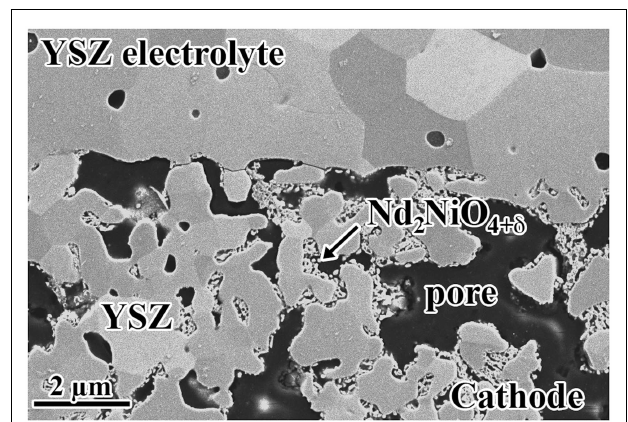
FIGURE 5 | SEM image of a mT-SOFC cathode/electrolyte interface showing ND-nickelate particles infiltrated into porousYSZ .